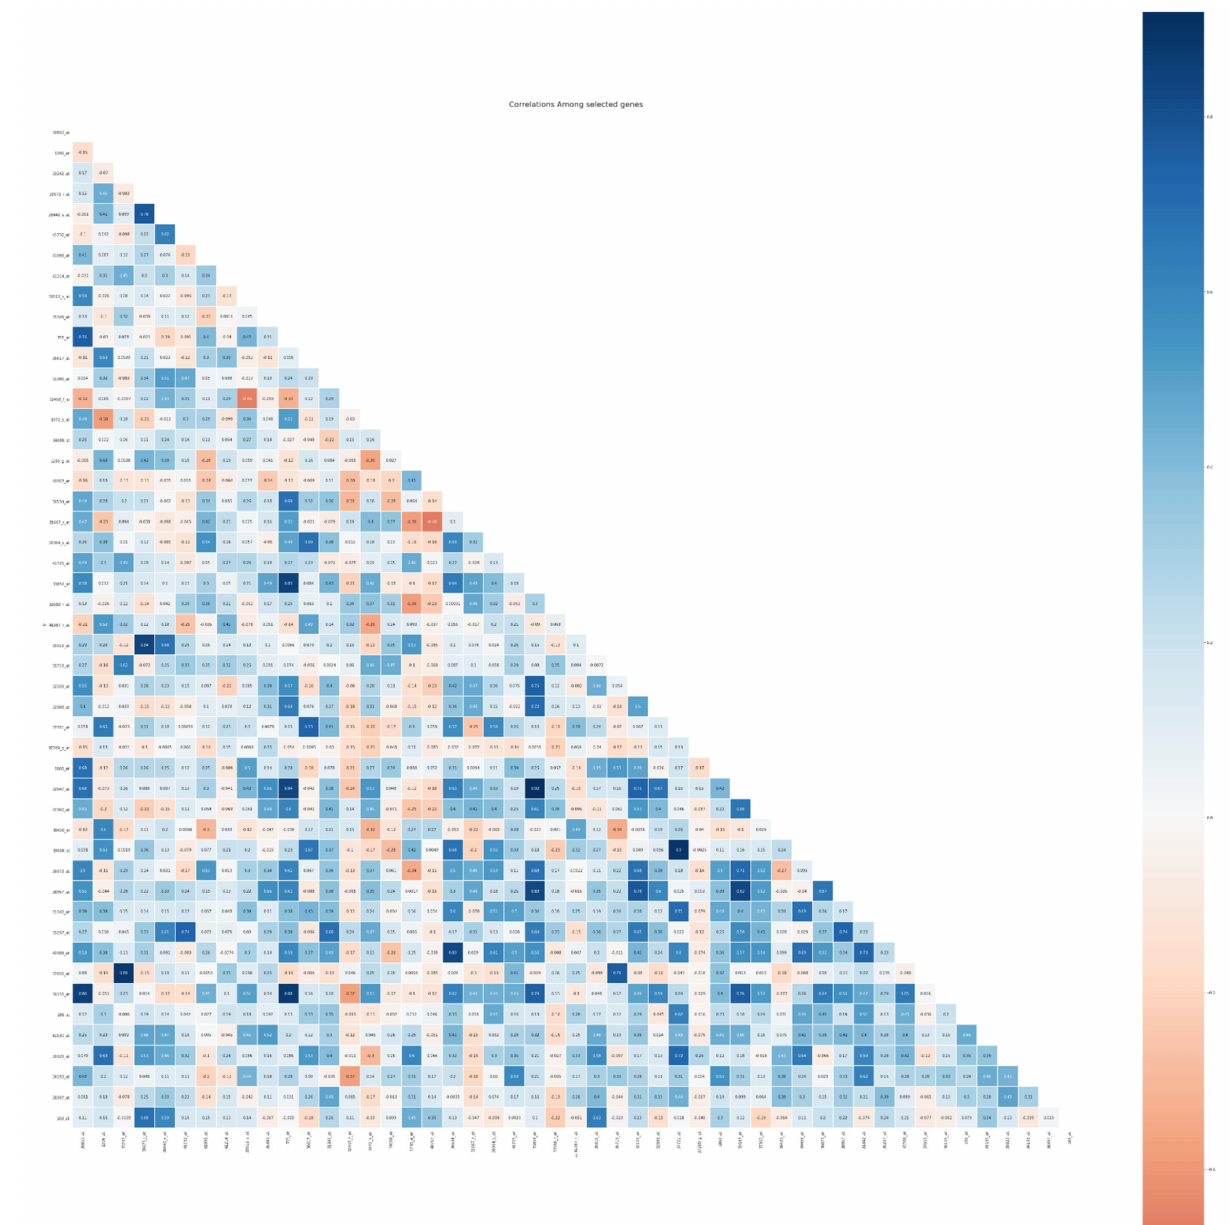
Figure 12. The correlation among the selected genes with the proposed hybrid